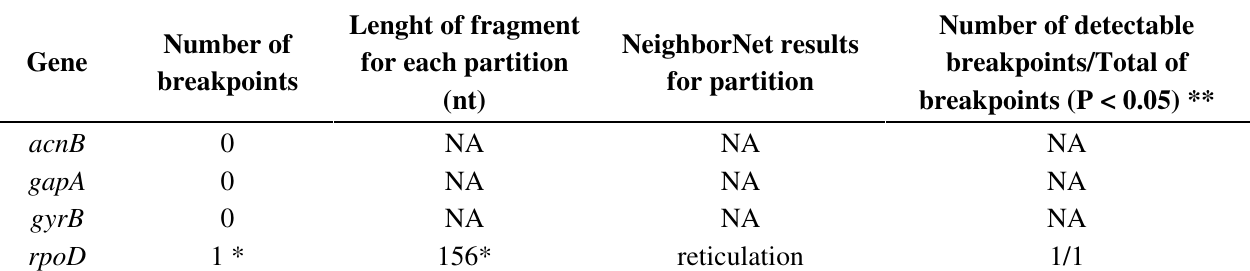
Table 4. Recombination breakpoints predicted in analyzed gene fragment using GARD (Genetic Algorithm for Recombination Detection) and the Akaike Information Criterion